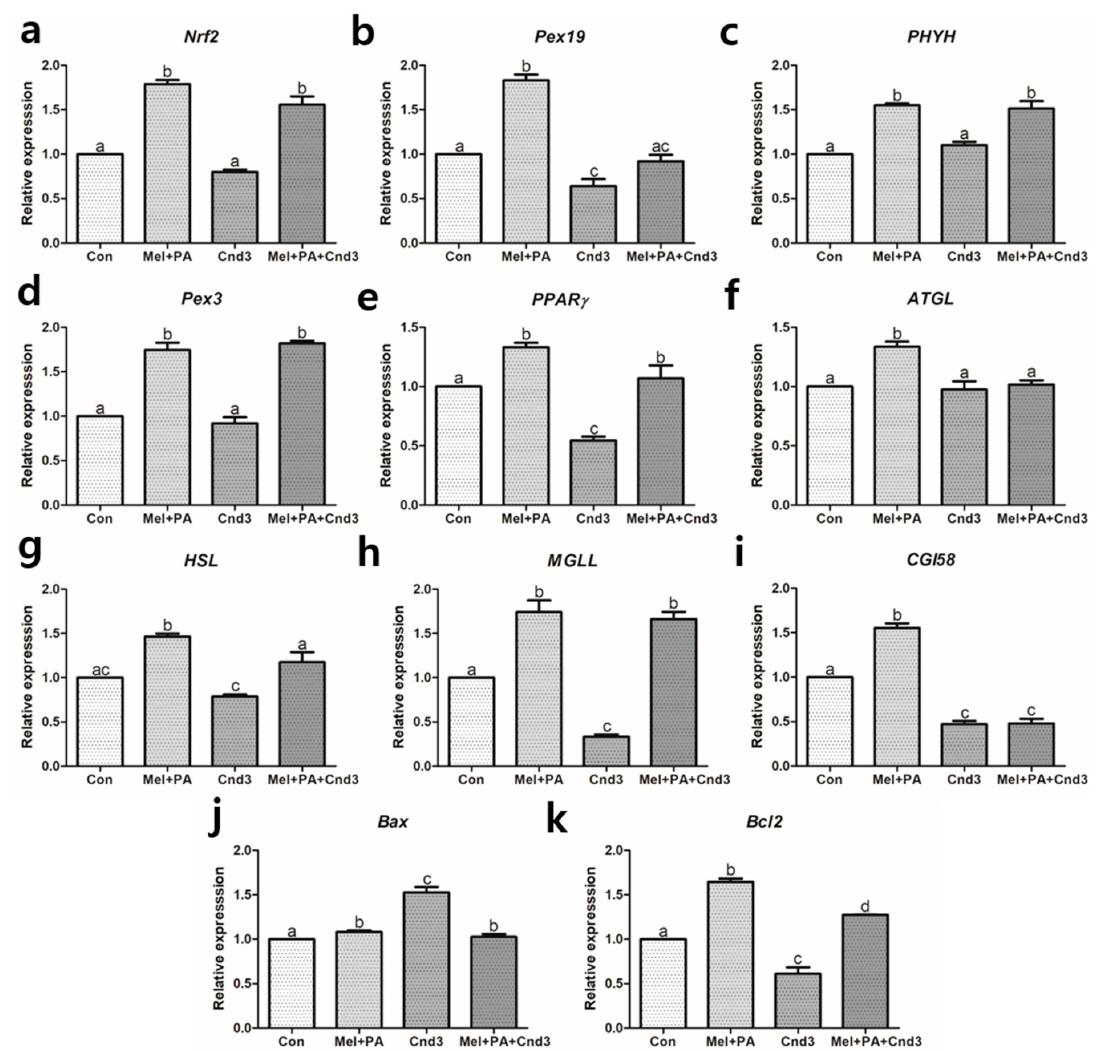
Figure 2. Gene expression evaluations of melatonin/PA treatment and Cnd3-injection on porcine two-cell embryos. The gene expressions of ( a ) Nrf2, the main factor in the Nrf2 signaling pathway, ( b – e ) factors that are related to peroxisomal activities, ( f – i ) lipid metabolism, and ( j , k ) apoptosis in the embryos were analyzed within the four groups. More than 200 embryos in each experimental group from six biological replications were used and real-time PCR was performed three times technically. Within the same mRNA, bars with different alphabetical letters are significantly different among the groups ( p < 0.05). Con, control; mel, melatonin, PA, phytanic acid; Cnd3, siRNA candidate 3.